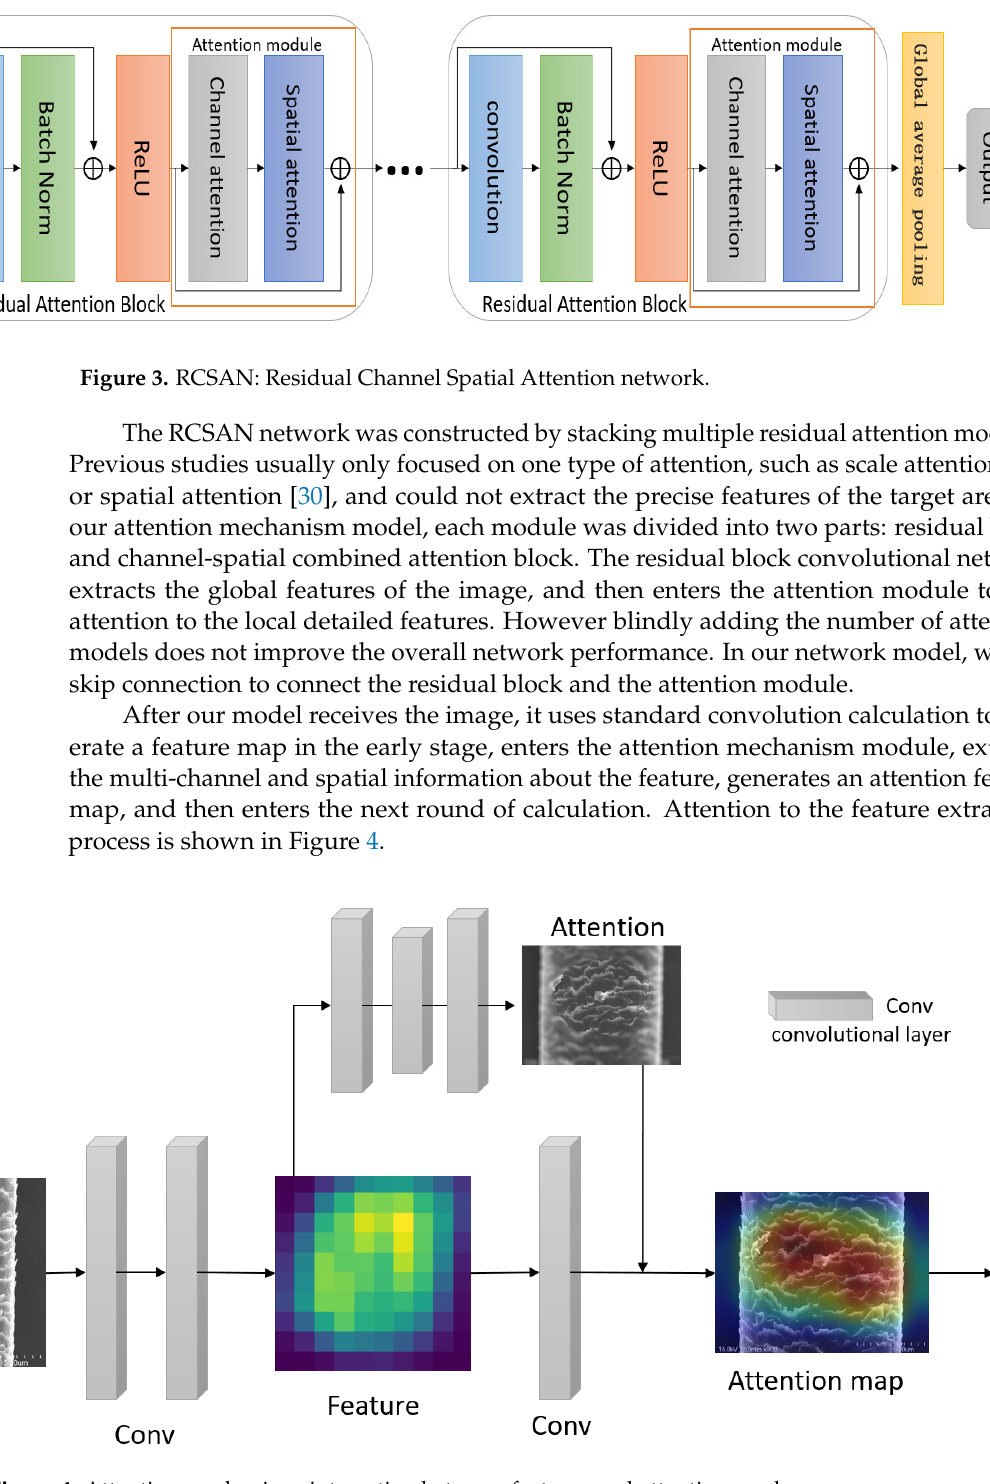
Figure 4. Attention mechanism, interaction between features and attention